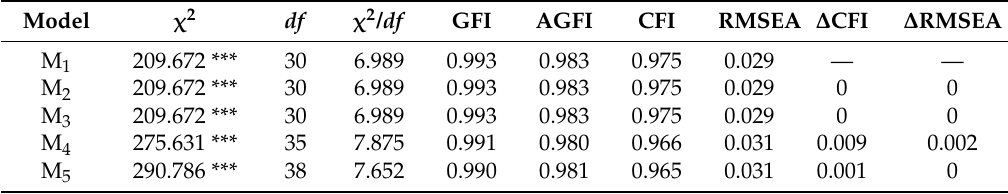
Table 5. Multi-group Model Invariance